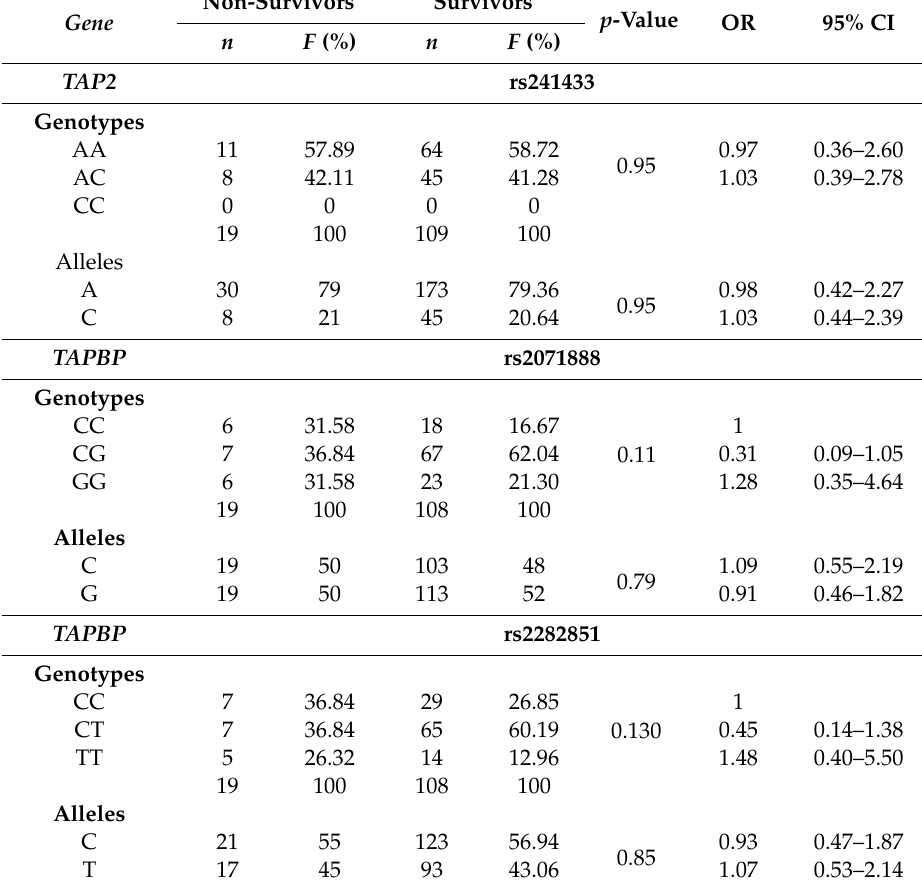
Table A2. Allele and genotype frequencies between Non-survivors and